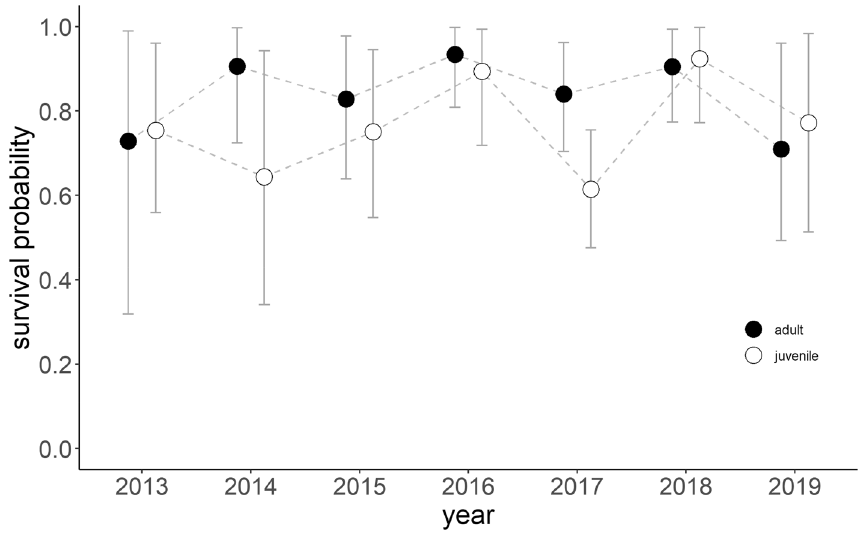
Figure 4. Annual survival probability of adult (black dot) and juvenile (white dot) WNC. The error bars indicate ± 95% confidence intervals. The figure was generated in RStudio v2022.02.2 (http:// www. rstud io. com) 61